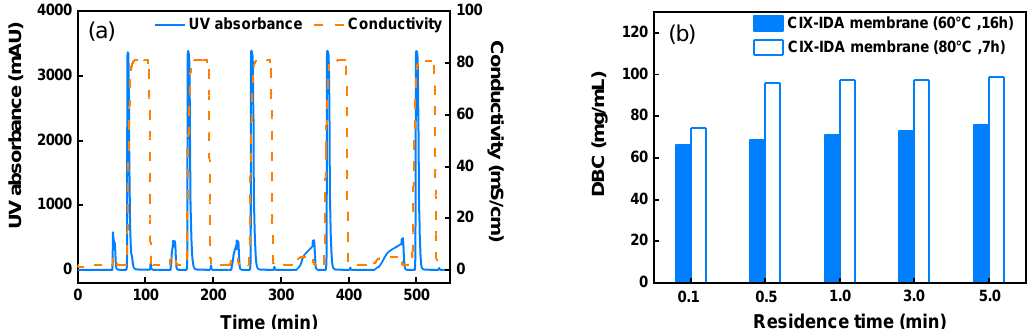
Figure 5. Results of five consecutive IgG bind-and-elute cycles at different RTs from 0.1 to 5.0 min. ( a ) Chromatograms for CEX-IDA membranes prepared by coupling IDA at 80 °C, 12 layers and ( b ) DBC comparison for membranes prepared at different IDA coupling conditions.